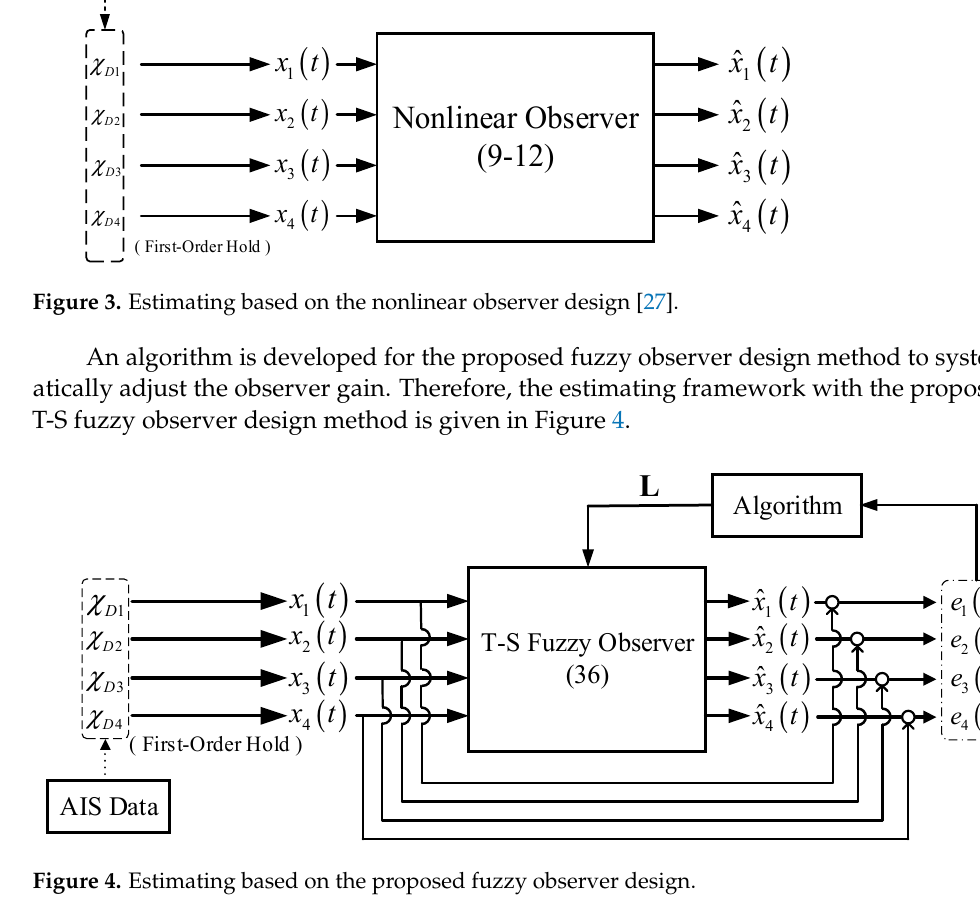
Table 1. Objective AIS data.